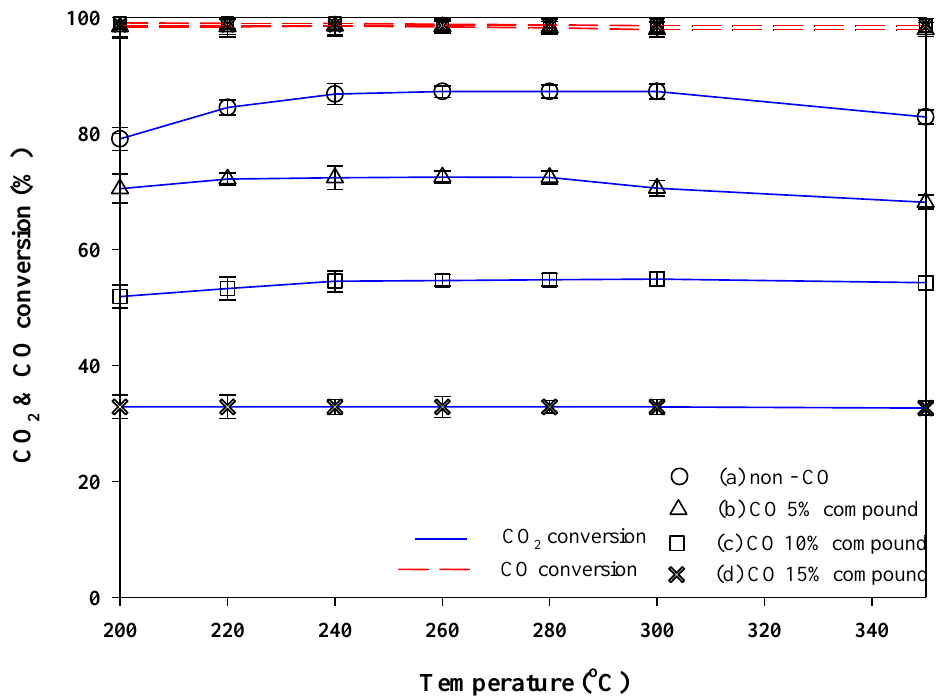
Figure 4. The effect on activity according to CO gas concentration (0 – 15%) in the CO 2 methanation reaction.